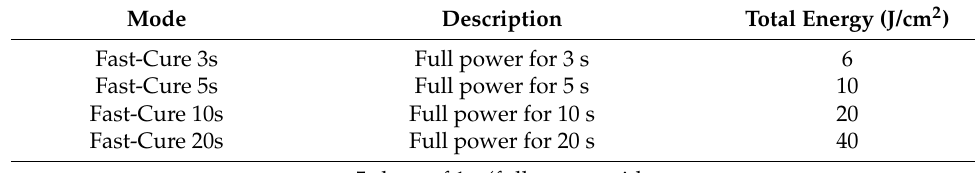
Figure 1. Pictures of samples: ( A ) rectangular specimen for flexural strength test; ( B ) disc-shaped specimen for Vickers microhardness test. Table 1. Characteristics of the photopolymerization modes.